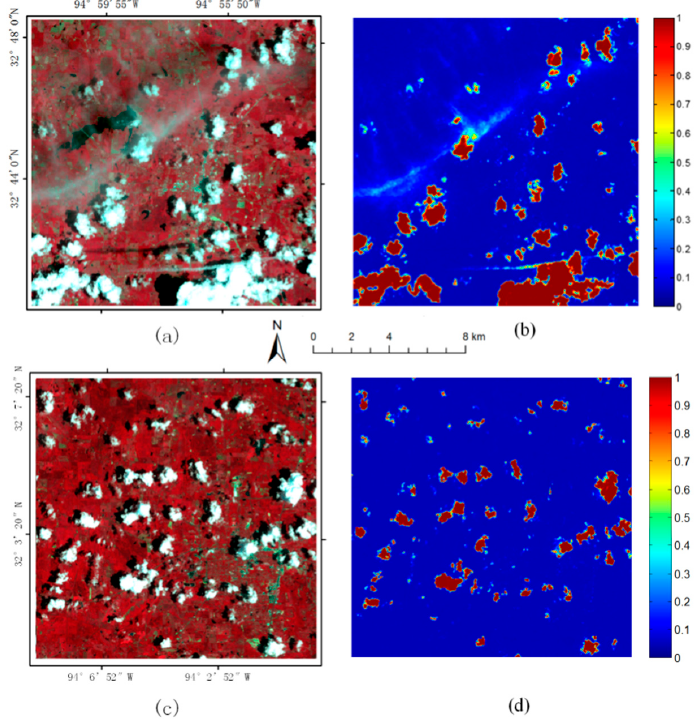
Figure 4. ( a – d ): ( a , c ) The original image of Landsat ETM+ images; and ( b , d ) the corresponding cloud density.